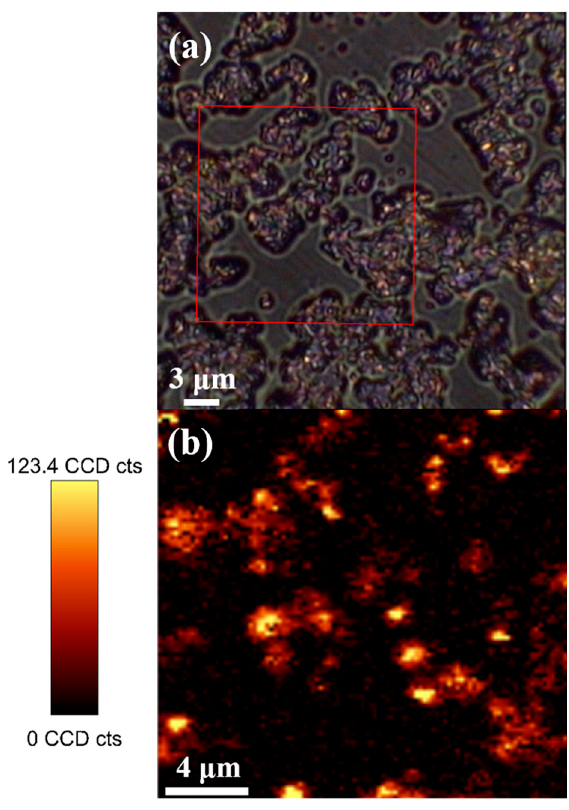
Figure 8. ( a ) Optical image of the sample with the Raman scanned area marked in red; ( b ) Raman image obtained using the integrated intensity of the PG band at 1000 cm − 1 , over a surface area of 10 × 10 µ m in MNP-Au(102) with adsorbed PG at initial concentration 10 − 1 M, (excitation at 633 nm, 500 µ W laser power, 100 points per line × 100 lines per image, 0.2 s). The vertical bar on the left of the Raman image shows the color profile and the relative intensity scale of the band at 1000 cm − 1 .